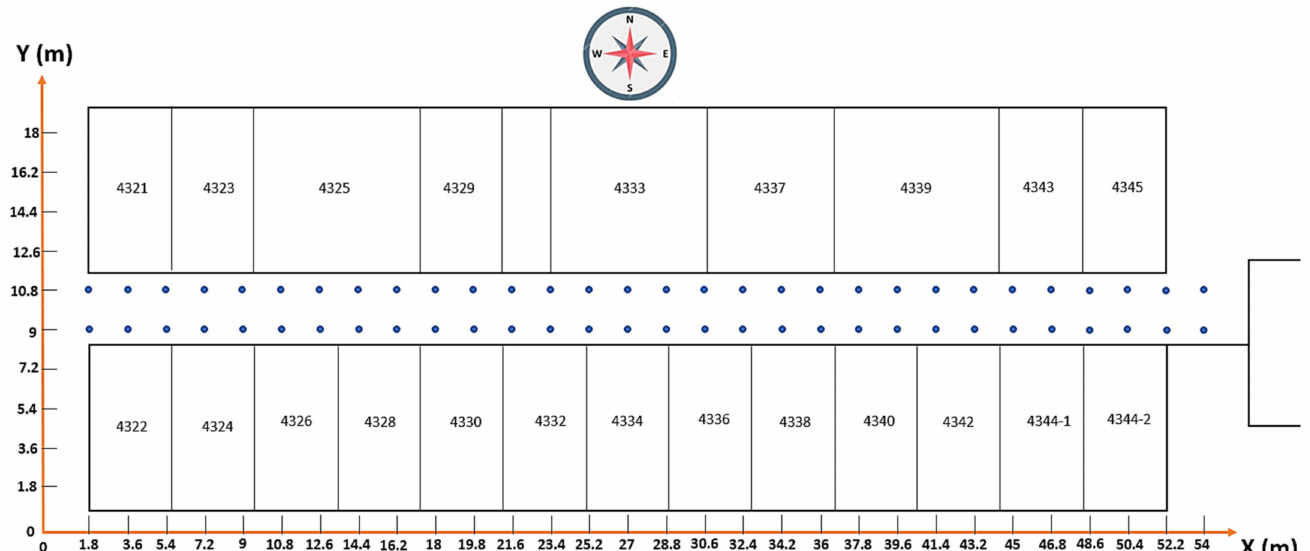
Figure 3. Experimental environment 1. The blue dots represent the RPs, and the total size of the experimental area is 20 m × 60 m.